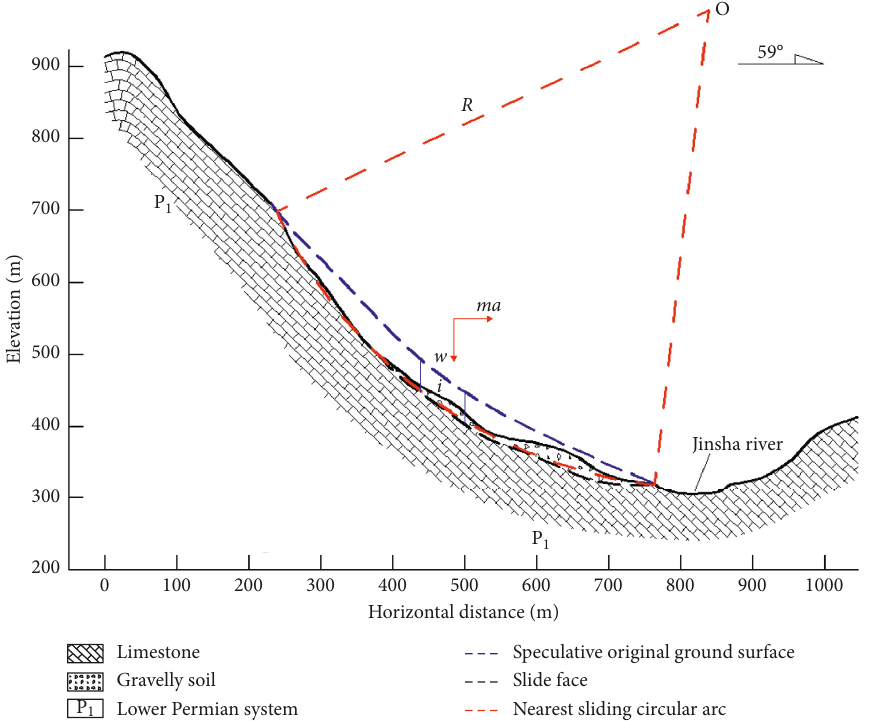
Figure 12: Cross section B-B